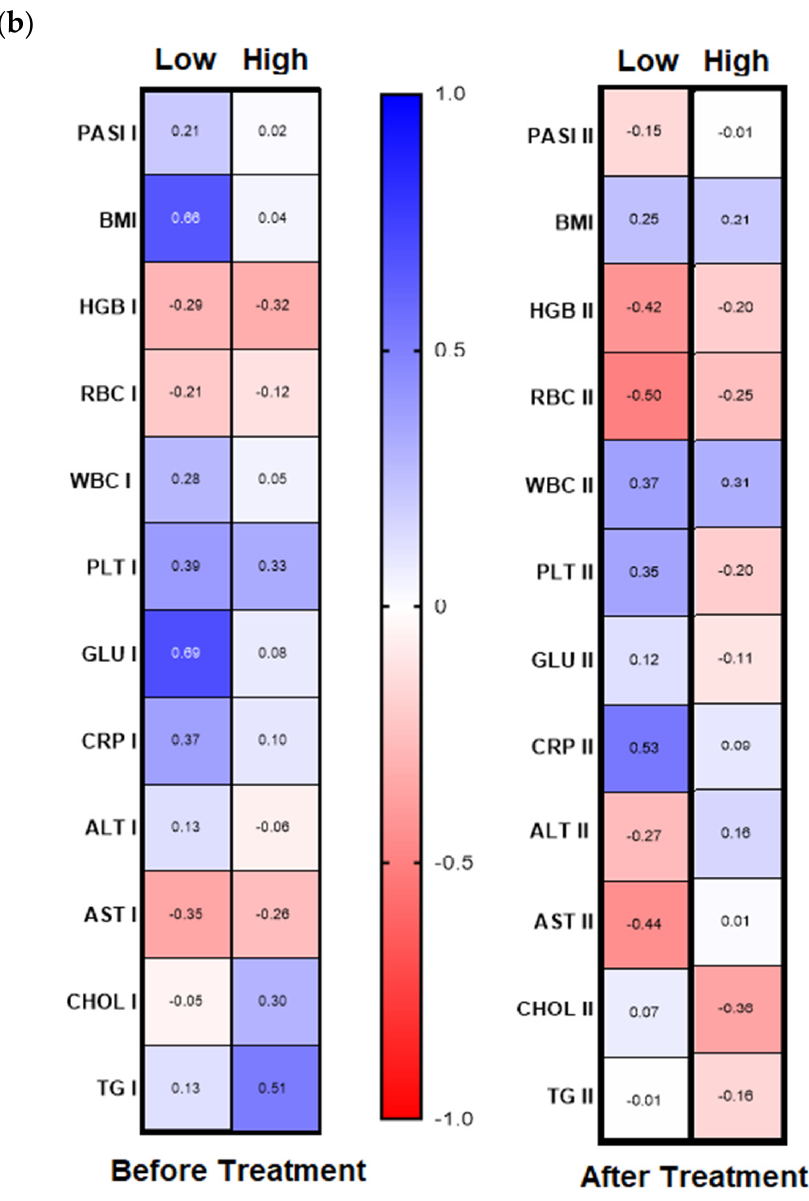
Figure 5. Chosen correlations before and after treatment with reference to duration of psoriasis ( a ) and the galectin-3 concentration threshold ( b ) with use of Spearman’s rank correlation.